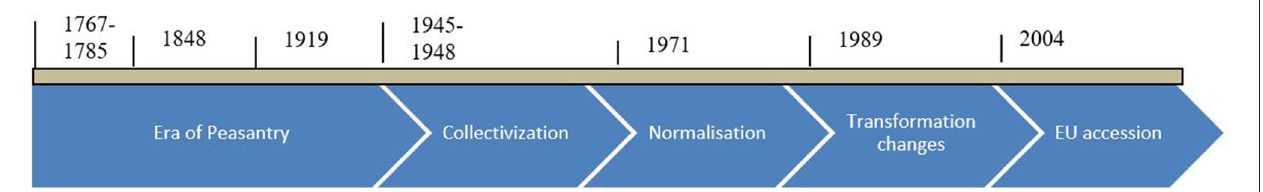
FIGURE 1 | Timeline of agricultural landscape development in Slovakia (Milestones in agricultural development: 1767—Teresian Land register; 1785—Patent on the abolition of slavery by Joseph II.; 1848—Act no. IX/1848 on the abolition of serfdom; 1919—I. Land Reform (Act 215/1919); 1945—II. Land Reform (Directive No. 4/1945); 1948—Act no. 69/1949 on United farmers’ cooperatives; 1971—United farmers’ cooperatives; 1989—Velvet revolution; 2004—Accession of SR to European